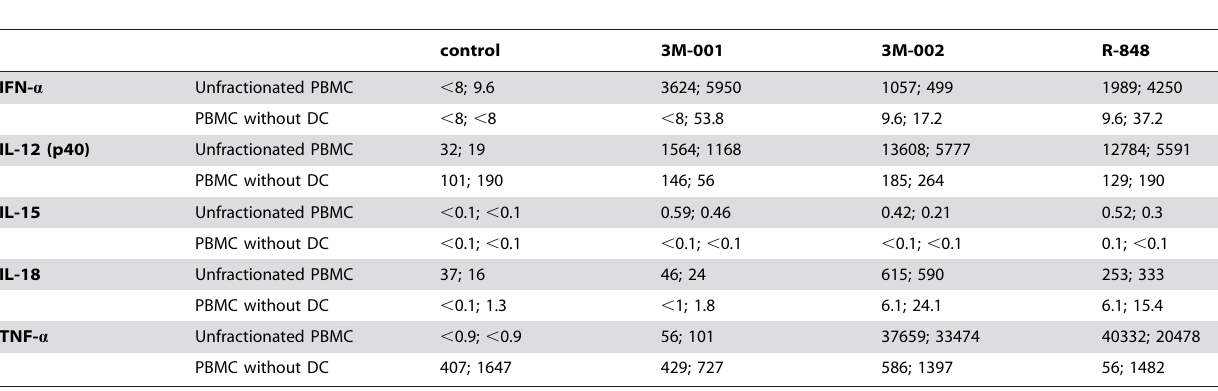
Table 2. Measurement of cytokines (pg/ml) one day after triggering TLR7 and/or 8 in unfractionated PBMC and PBMC without DC (n=2).